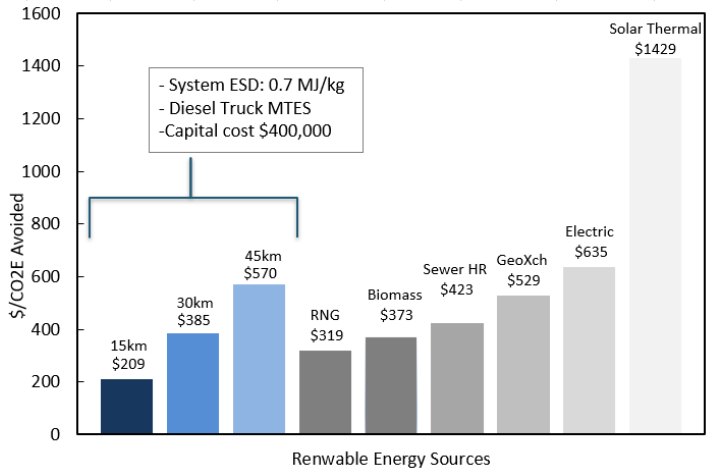
2 e with different IWH locations and truck modes. Appl. Sci. 2021 , 11 , x FOR PEER REVIEW